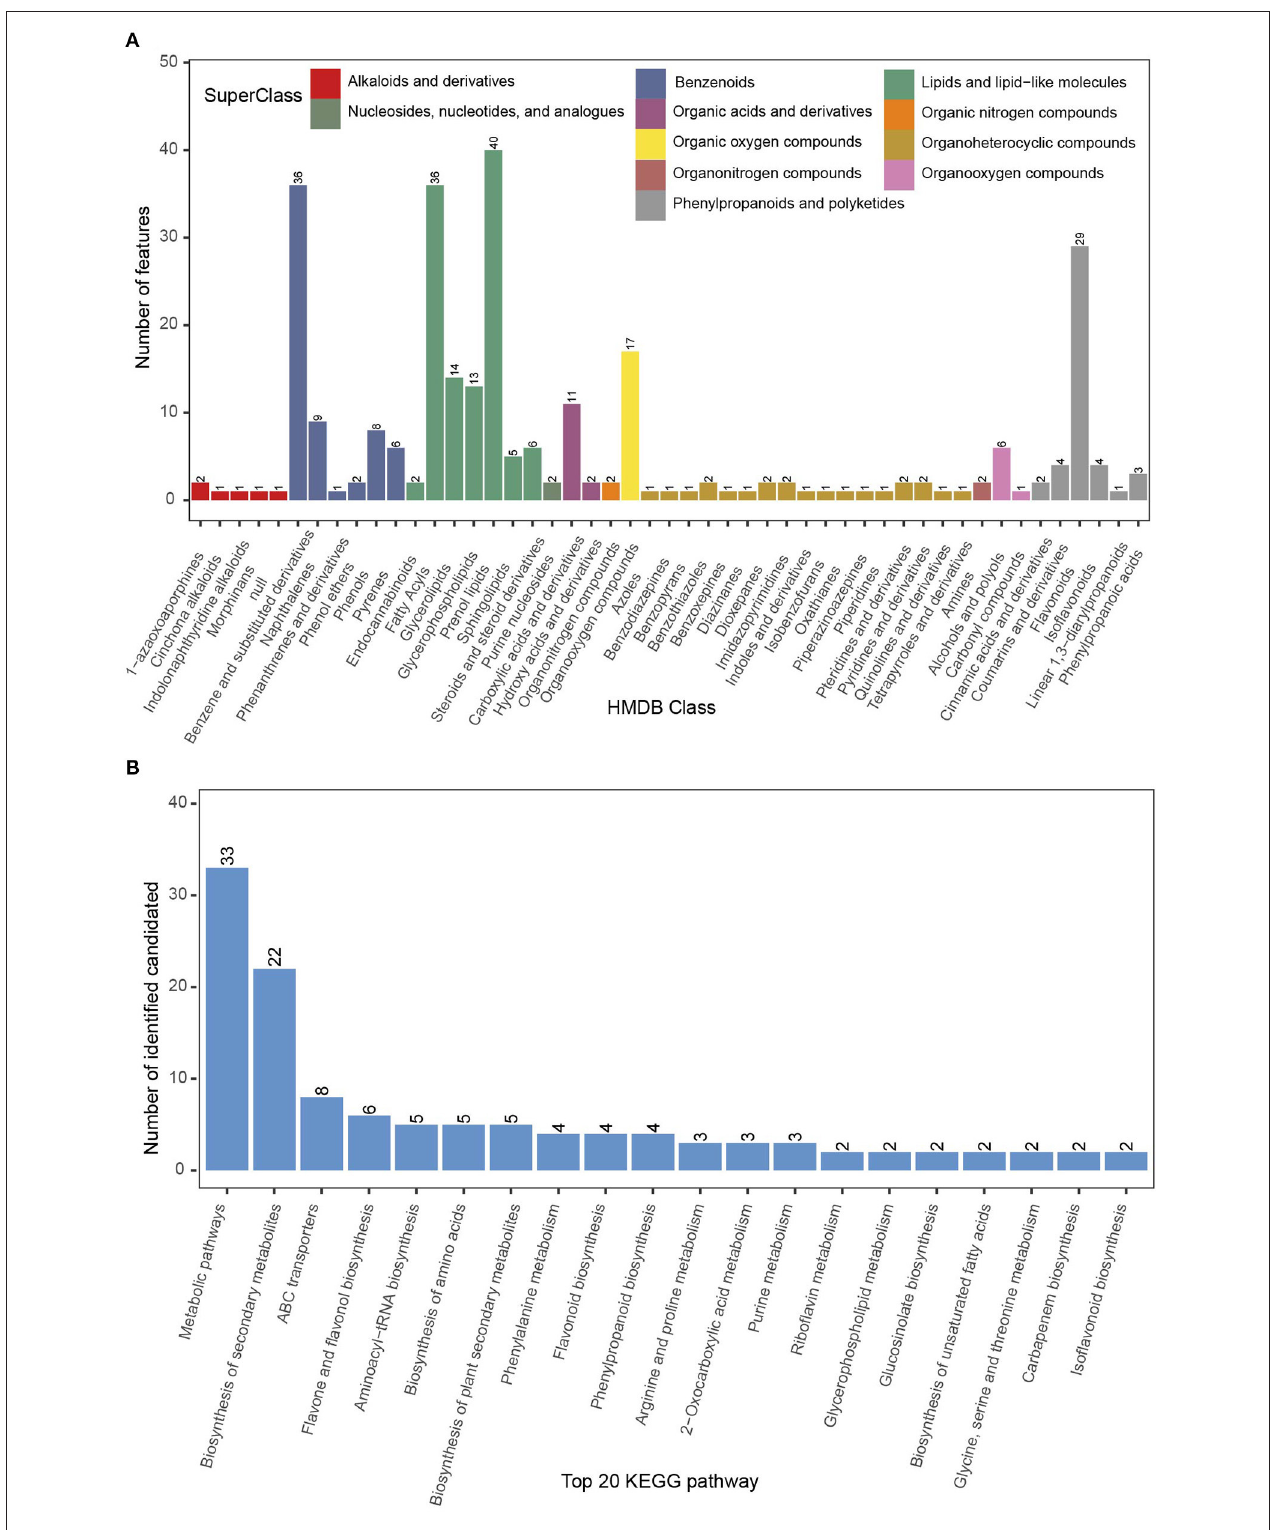
FIGURE 6 | Leaf secondary metabolite profile of the phyllosphere of Chinese fir. (A) Metabolite classification based on HMDB data; (B) number of candidate metabolites among the 20 highest ranked KEGG pathways.